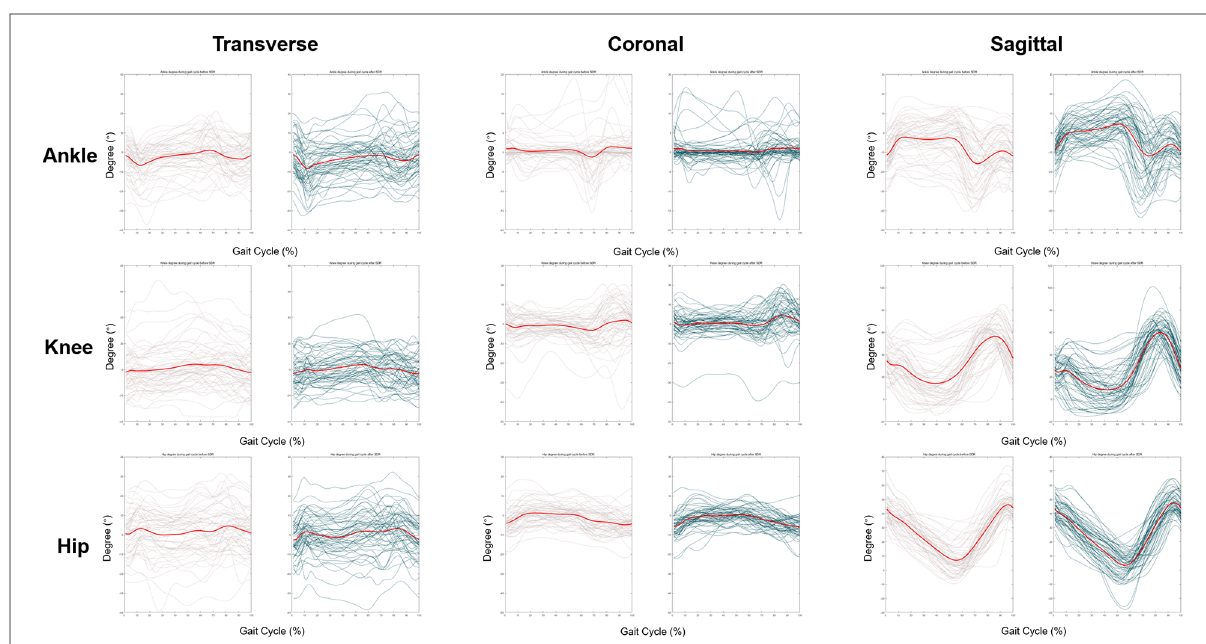
FIGURE 3 Kinematic curves of ankle, knee and hip in affected lower extremities at transverse, coronal and sagittal plane. Transverse plane: internal rotation and external rotation. Before the surgery, the median degree of ankle, knee, hip ranged from − 2.1° to 3.3°, − 6.2° to 5.8°, − 8.3° to 3.3° in transverse plane, respectively. After SDR, the median degree of ankle, knee, hip ranged from − 11.8° to 3.1°, − 8.9° to 8.7°, − 5.7° to 7.0° in transverse plane, respectively. Positive value means internal rotation; negative value means external rotation. Coronal plane: abduction and adduction. Before the surgery, the median degree of ankle, knee, hip ranged from − 7.4° to 3.9°, − 8.5° to 5.7°, − 3.3° to 6.6° in coronal plane, respectively. After SDR, the median degree of ankle, knee, hip ranged from − 1.9° to 1.3°, − 3.6° to 7.3°, − 8.0° to 2.3° in coronal plane, respectively. Positive value means abduction;